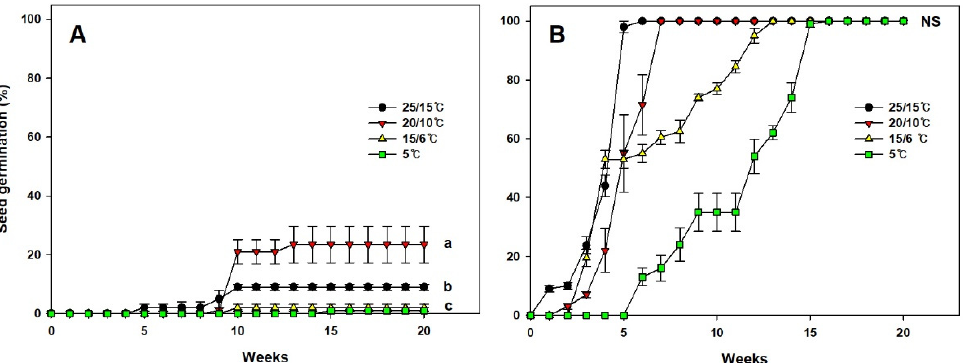
Figure 3. Time periods of water absorption by Hovenia dulcis seeds after sulfuric acid scarification for 1 h at ( A ) 0, ( B ) 1, ( C ) 12, and ( D ) 24 h. Dyeing was performed using safranin stain. Arrows indicate hilar fissure.